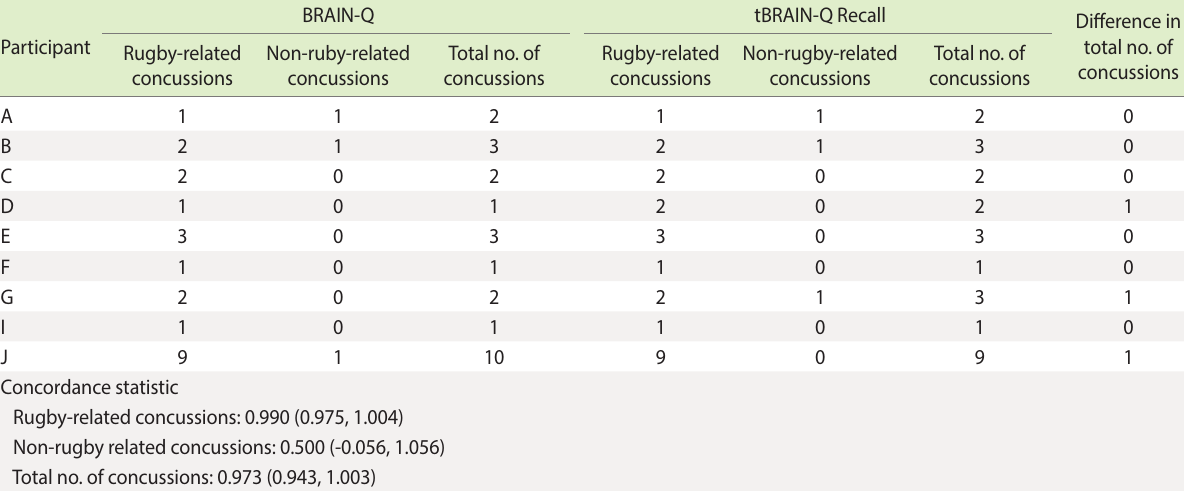
Table 4. Total number of rugby and non-rugby-related concussions reported through the BRAIN-Q (initial assessment) and tBRAIN Recall (follow-up phone call) Participant